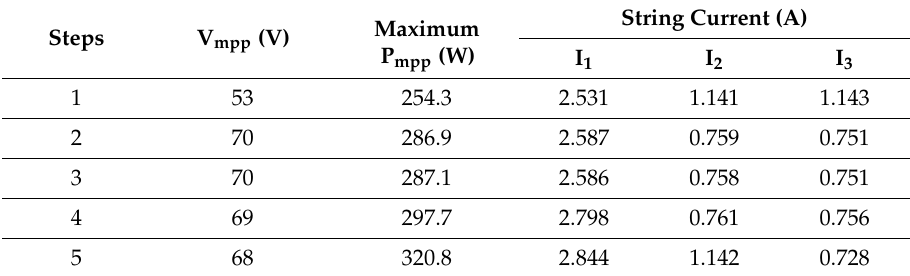
Table 3. Electrical parameters obtained for di ff erent